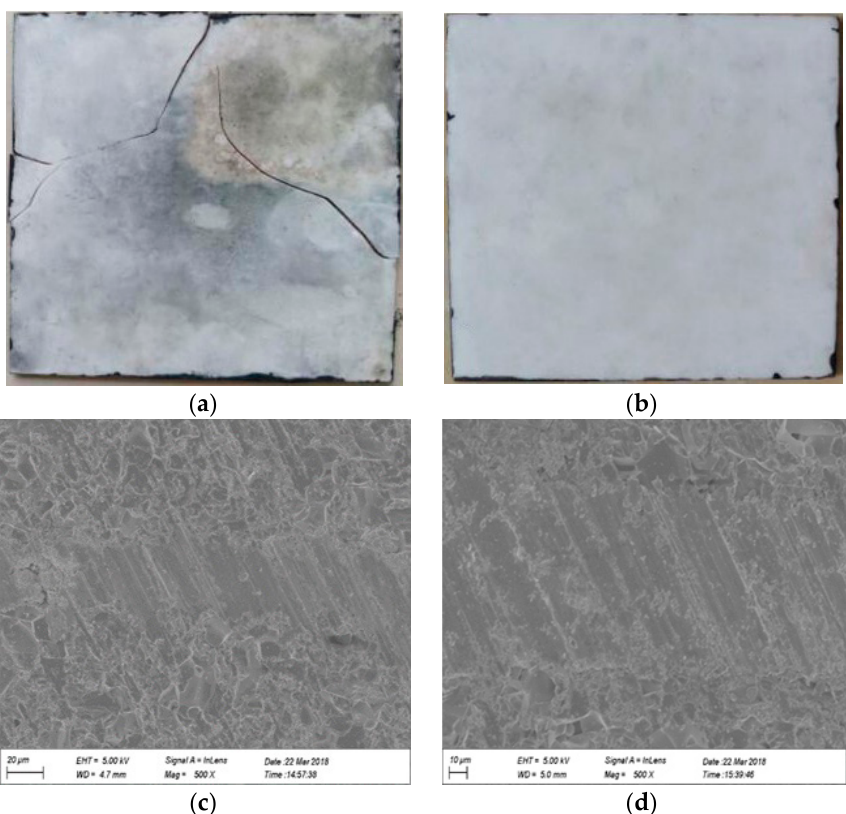
Figure 8. Morphology of the composite ceramic panel after the electromagnetic heating test: ( a ) with a single magnetic interlayer; ( b ) with a three-layer gradient; ( c ) cross-section of the panel with a single magnetic interlayer; and ( d ) cross-section of the panel with a three-layer gradient.